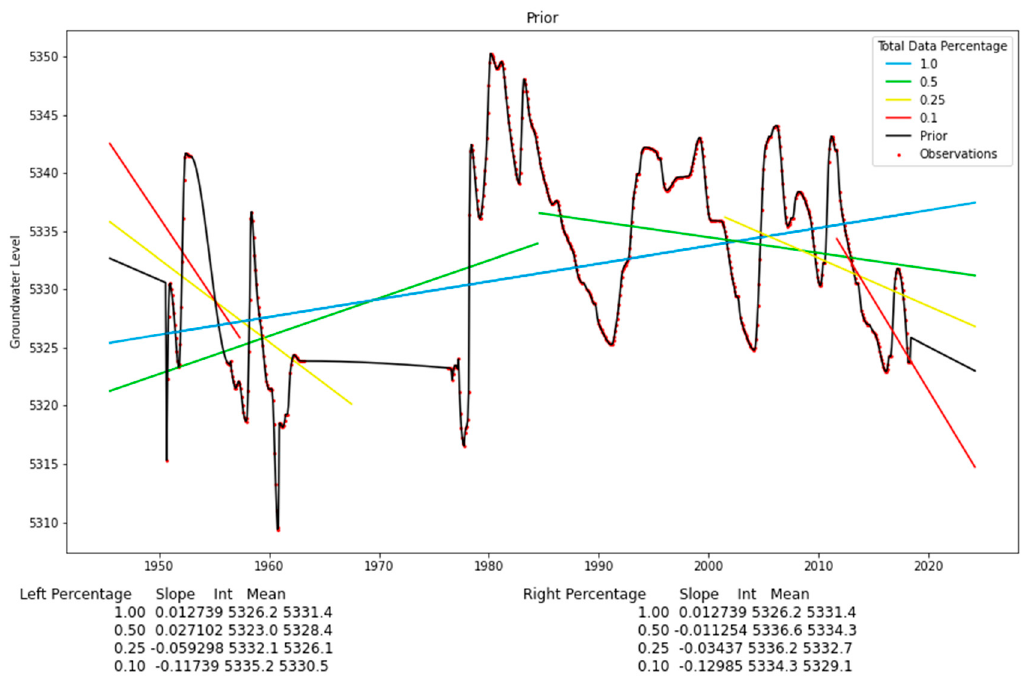
Figure 5. Prior for a well in an aquifer generated by interpolating and extrapolating the observed groundwater data.